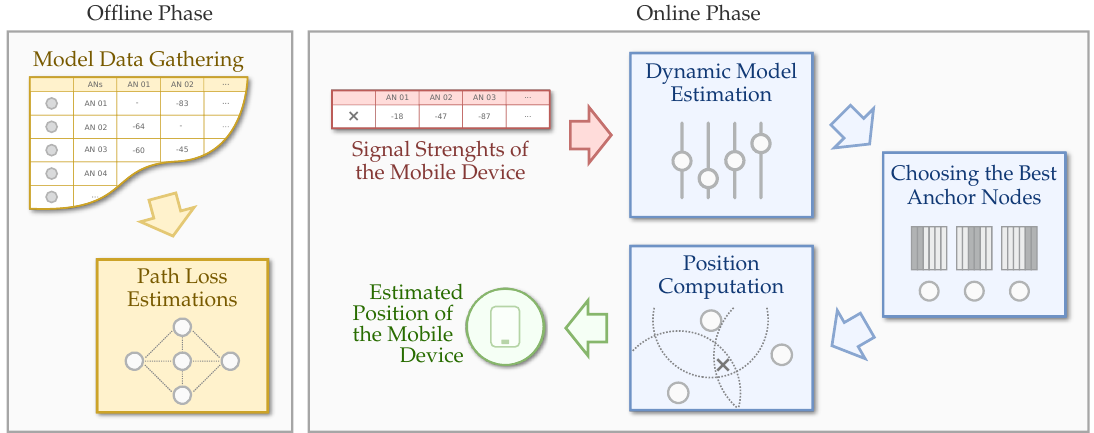
Figure 1. Phases and components of our PoDME